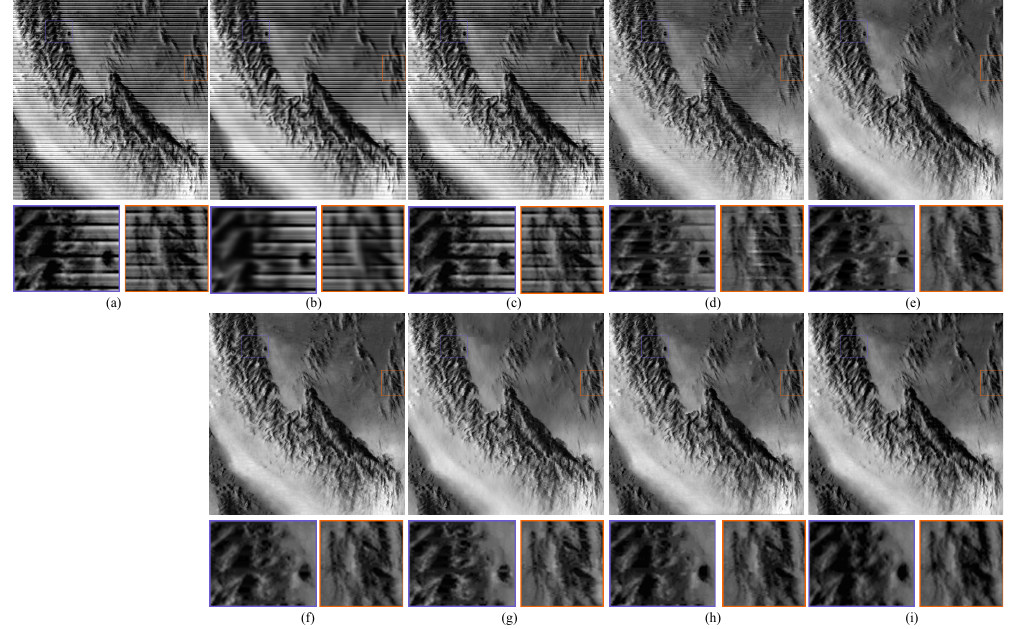
Figure 18. Results of different methods on Terra MODIS data band 27 R2. ( a ) original; ( b ) BM3D; ( c ) SNRCNN; ( d ) GF-based; ( e ) WAFT; ( f ) UV; ( g ) HUTV; ( h ) SUV; ( i )